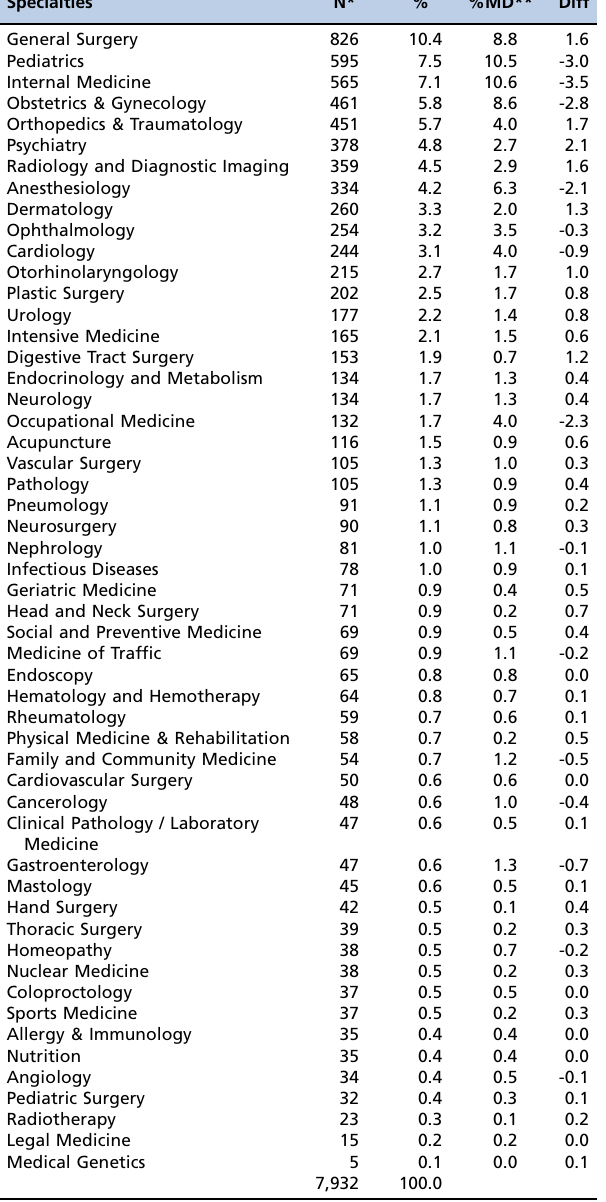
Table 2 - Medical specialties of physicians who graduated from the USP Medical School. Specialties General